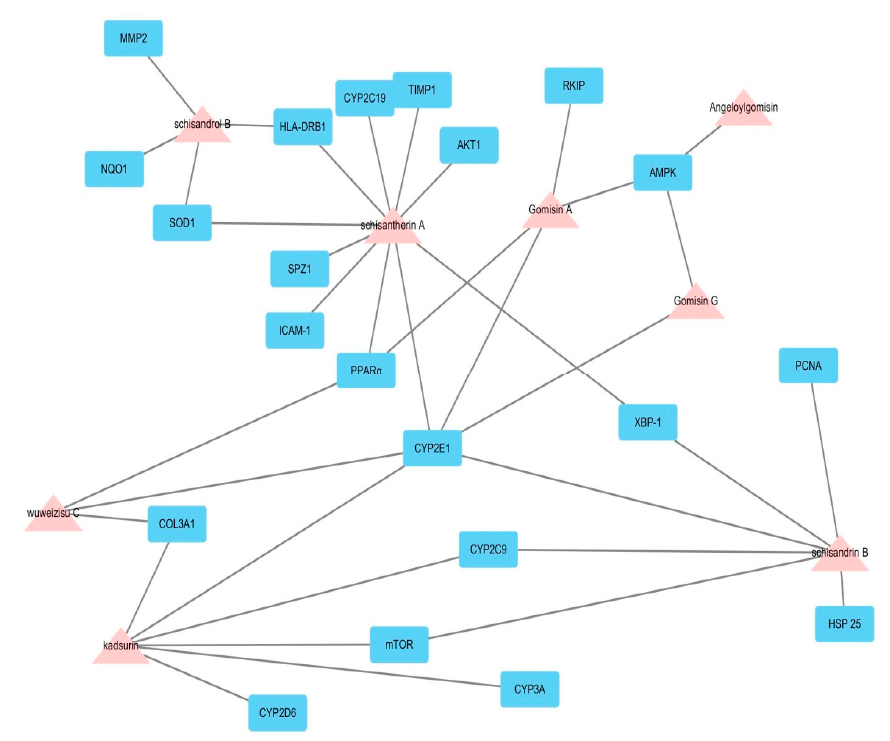
Figure 1. The compound–target network plotting.